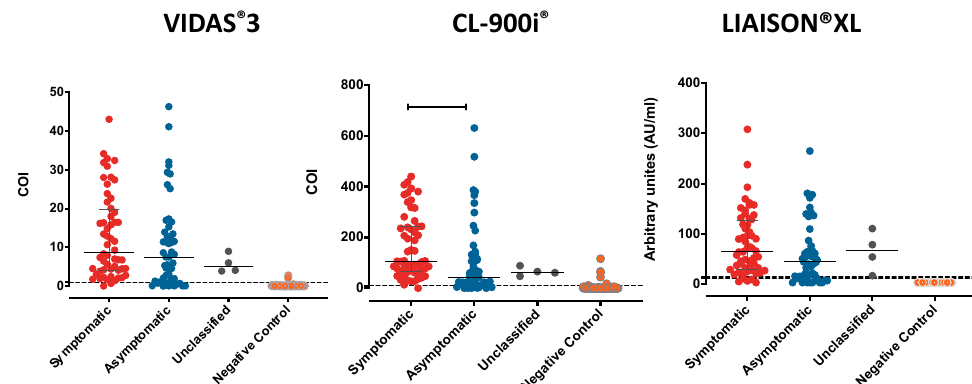
Figure 2. Distribution of numerical results obtained from each automated analyzer. Results are represented as dot plots to review the scatter of values around the prespecified assay cut-off (shown as dashed lines). Data are presented for 111 RT-PCR confirmed SARS-CoV-2 samples (symptomatic, asymptomatic, and unclassified), and 127 pre-pandemic control samples for each of the three automated assays. The dashed lines represent the cut-off values for the automated assays. The continuous lines represent the median and confidence interval (CI) for each group. One-way analysis of variance (ANOVA) was used to compare the differences between groups.